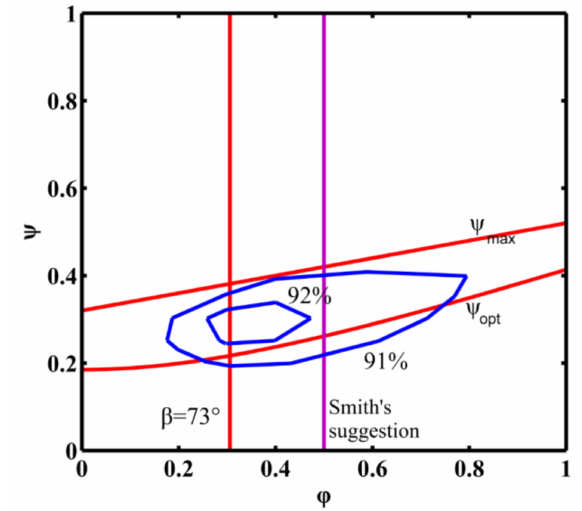
Figure 4. Sensible range of flow coefficient and work coefficient.